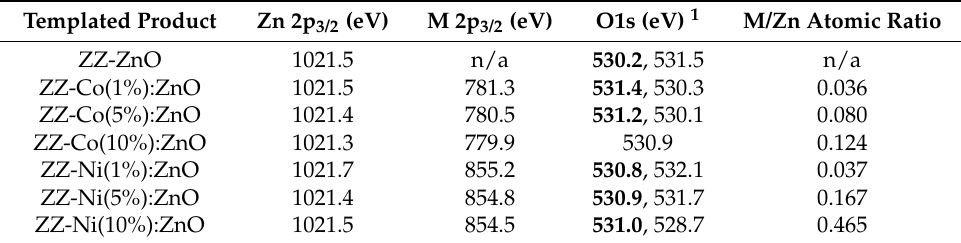
Table 2. Summary of XPS surface analysis results on ZZ leaf templated ZnO materials. Templated